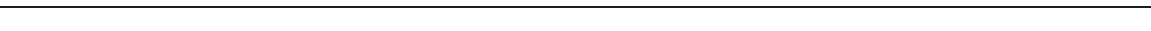
Fig. 4 Gene expression changes in Yap1 , Wwtr1 iPCKO pericytes. a MA-plots of differentially regulated genes between P8 Yap1 , Wwtr1 iPCKO and control pericytes. The x -axis represents the mean normalized counts and the y -axis shows the log2 fold change. Differentially regulated genes are represented by red colored points (FDR-adjusted P -value < 0.01 and absolute log2 fold change > 0.5). b Gene ontology analysis for signi fi cantly differentially regulated genes (RNA-seq analysis) in Yap1 , Wwtr1 iPCKO and control pericytes. c RiboTag and RNA-seq-based expression levels of the indicated transcripts relative to P8 control. RPKM (reads per kilobase of exon per million mapped reads) values obtained from RNA-seq are shown. Data represents mean ± s.e.m. ( n = 3). d RT-qPCR analysis of indicated transcripts in immunoprecipitated (IP) RNA from P7 Pdgfrb(BAC)-CreERT2 Rpl22HA lung, brain, heart, retina, and inguinal white adipose tissues (WAT). Data represents mean ± s.e.m. ( n = 4 mice). e RT-qPCR analysis of Hgf and Met expression in freshly sorted GFP + , CD31 + or EpCAM + cells from P7 Pdgfrb-CreERT2 R26-mT/mG lungs. Data represents mean ± s.e.m. ( n = 4 mice). f High magni fi cation images of P12 lungs stained for SFTPC (green), c-Met (red), and RAGE (blue). Arrows indicate SFTPC + c-Met + cells. Scale bar, 15 µ m. g Hgf expression in freshly sorted PDGFR β +